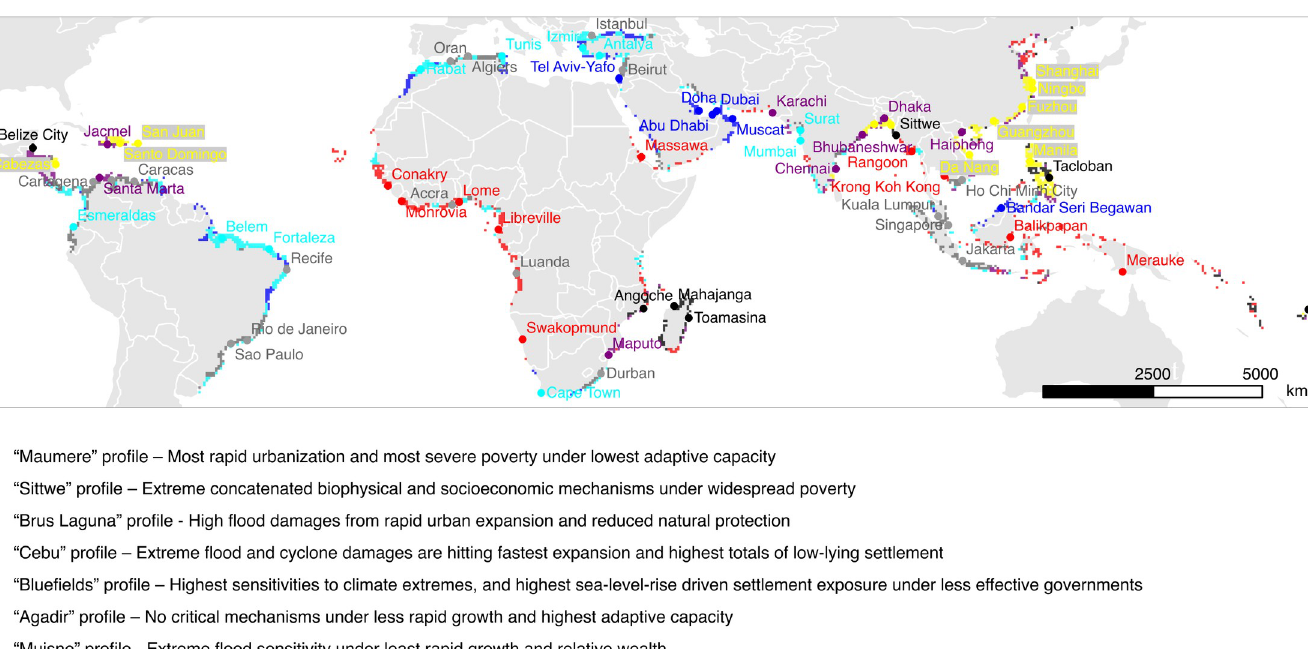
Fig 3. Spatial distribution of the seven urban vulnerability profiles under rapid coastal urbanization, and examples of cities located in these profiles. See Table 2 for a short description of the respective profiles.